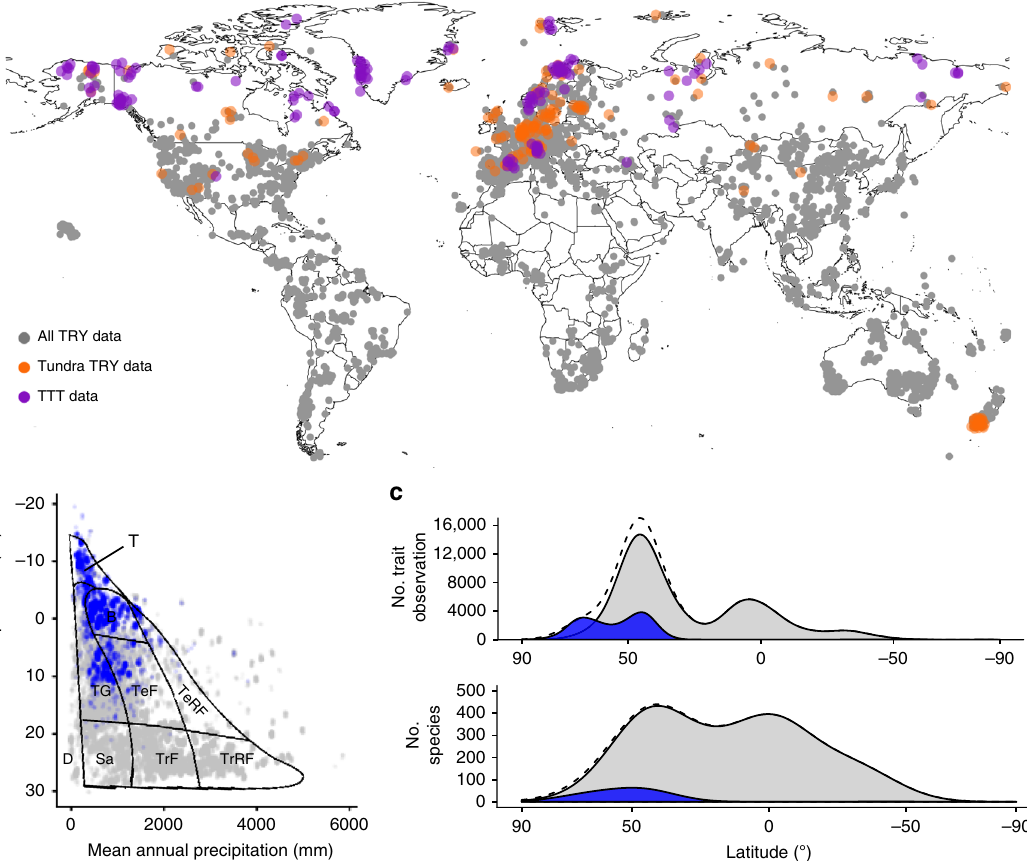
Fig. 1 Tundra trait data within geographical and climate space. a Map of trait observation sites for six plant traits, indicating global trait observations in TRY (grey points), tundra species observations in TRY (orange points) and TTT data (purple points). b Location of trait collection sites in climate space for all available plant species (grey) and tundra species (blue). Major biomes are mapped onto climate space (T-Tundra; B-Boreal Forest; TG-Temperate Grassland; TeF-Temperate Deciduous Forest; TeRF-Temperate Rain Forest; TrF-Tropical Deciduous Forest; TrRF-Tropical Rain Forest; Sa-Savanna; D – Desert) 146 . c Number of trait observations (upper panel) and species (lower panel) for all available plant species (grey) and tundra species (blue), by latitude. Dotted curves indicate global distributions with the inclusion of TTT collected